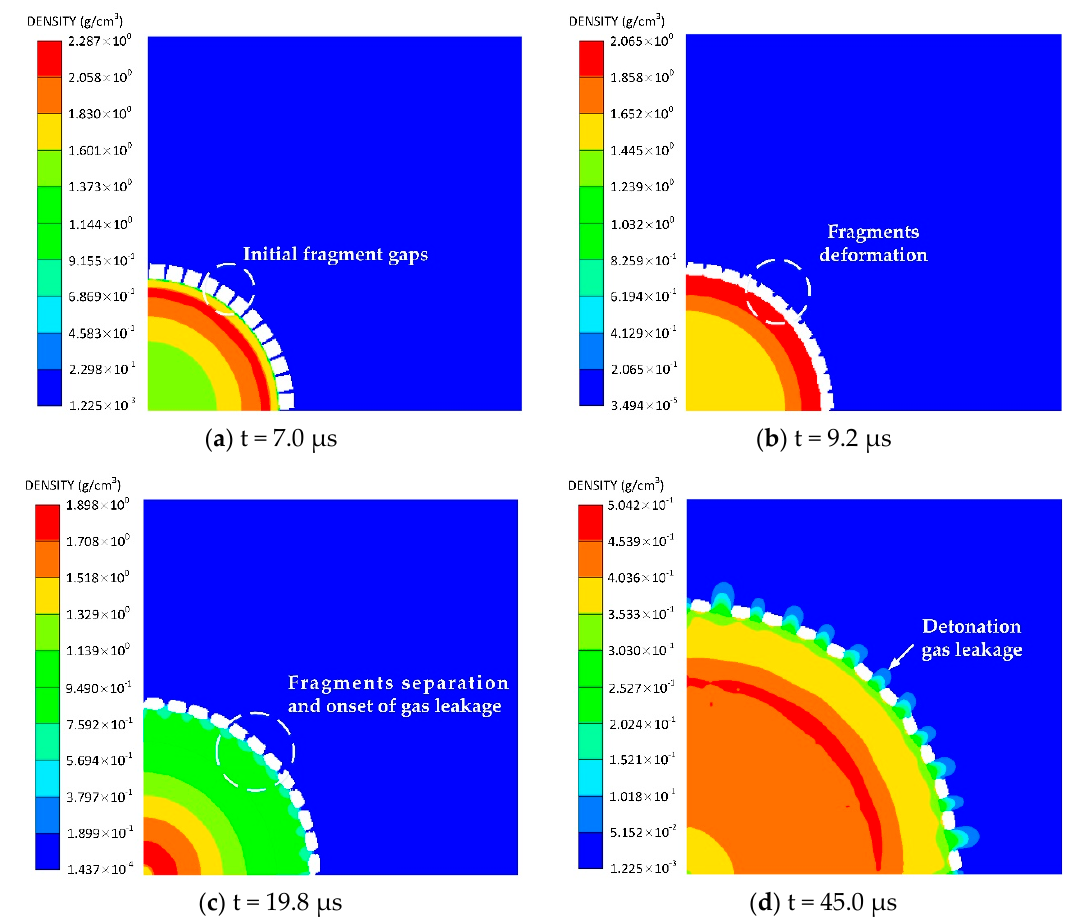
Figure 5. Density of Euler domain (detonation gas and air) after detonation of explosive: ( a ) t = 7.0 μ s, ( b ) t = 9.2 μ s, ( c ) t = 19.8 μ s, ( d ) t = 45.0 μ s. (a)–(d) shows the fragment deformation and separation process as well as the detonation gas leakage